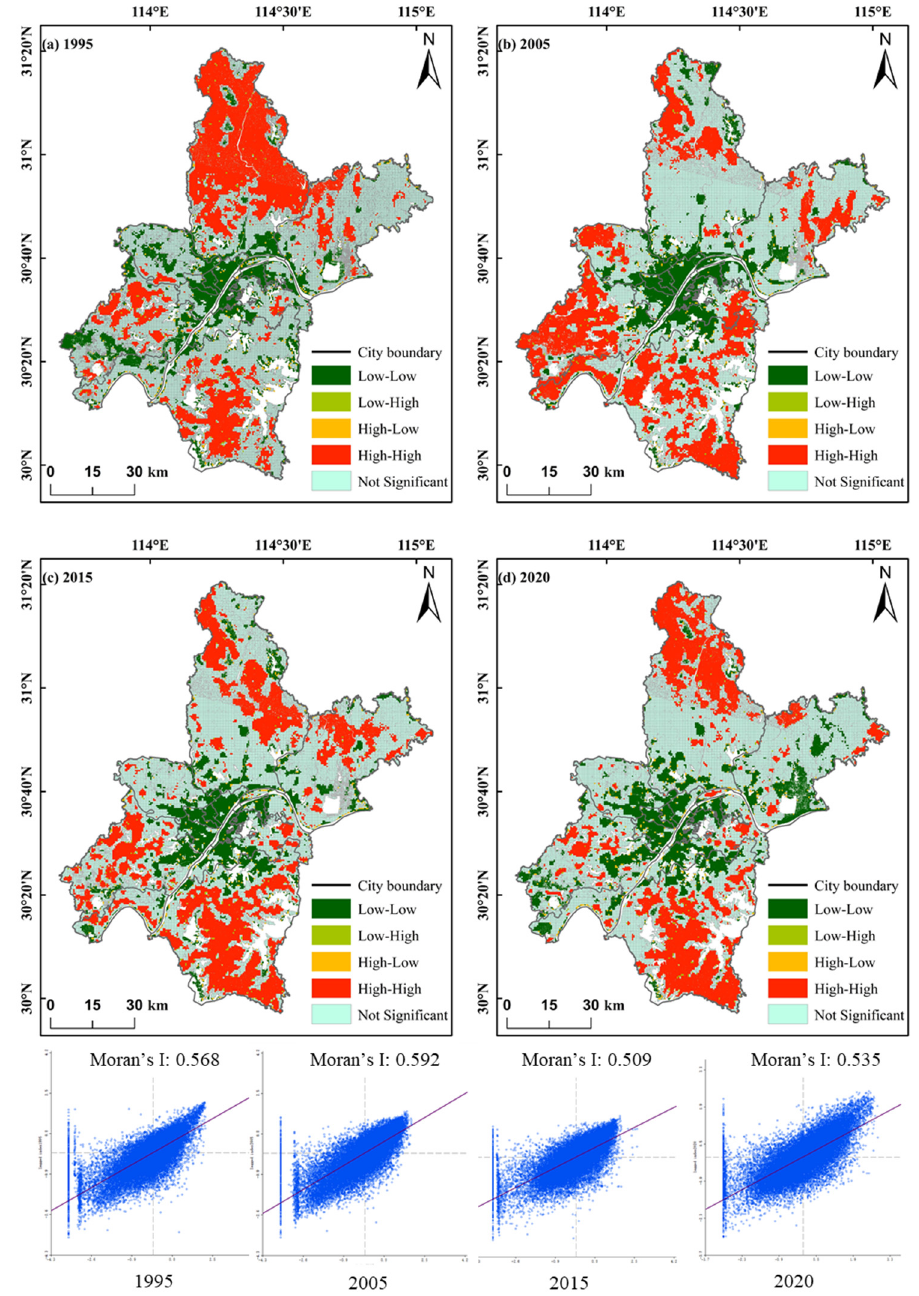
Figure 8. Spatial correlation and Moran index scatterplot of IRSEI from 1995 to 2020 in Wuhan city. ( a ) SA with 1995, ( b ) SA with 2005, ( c ) SA with 2015 and ( d ) SA with 2020. (Note: SA—Spatial autocorrelation).